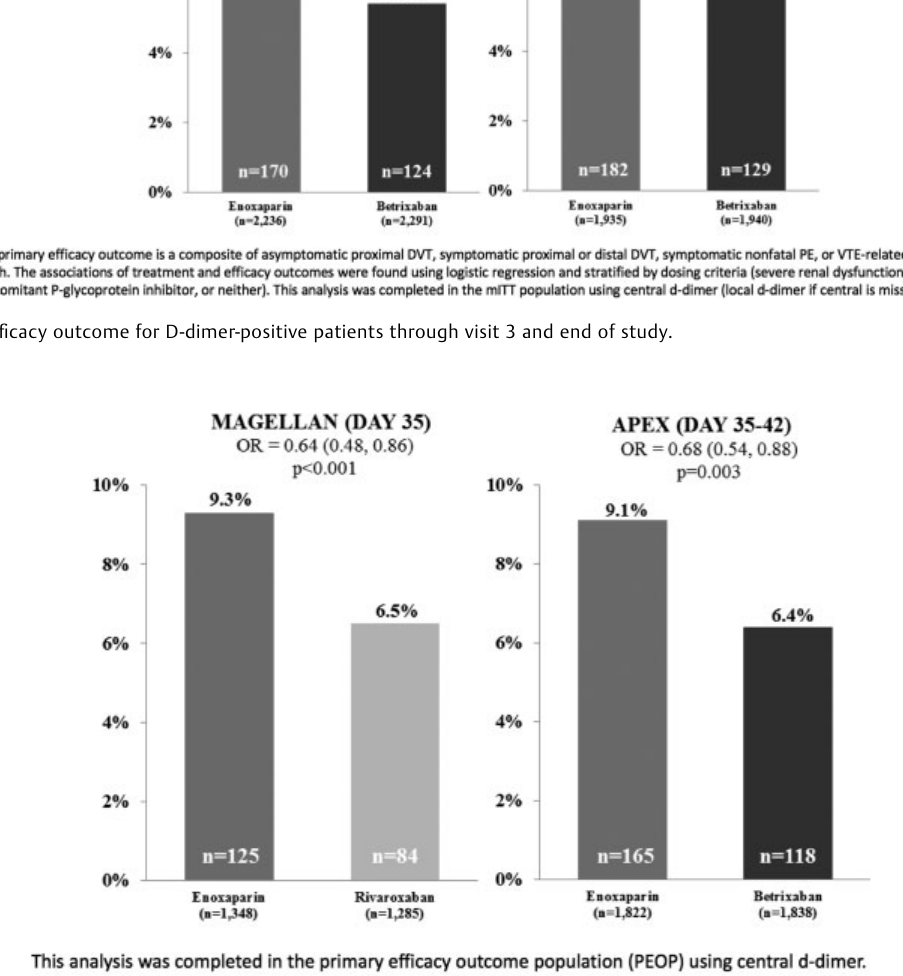
Fig. 2 Primary ef fi cacy outcome for D-dimer-positive patients through day 35 in APEX and MAGELLAN. TH Open Vol. 2 No.